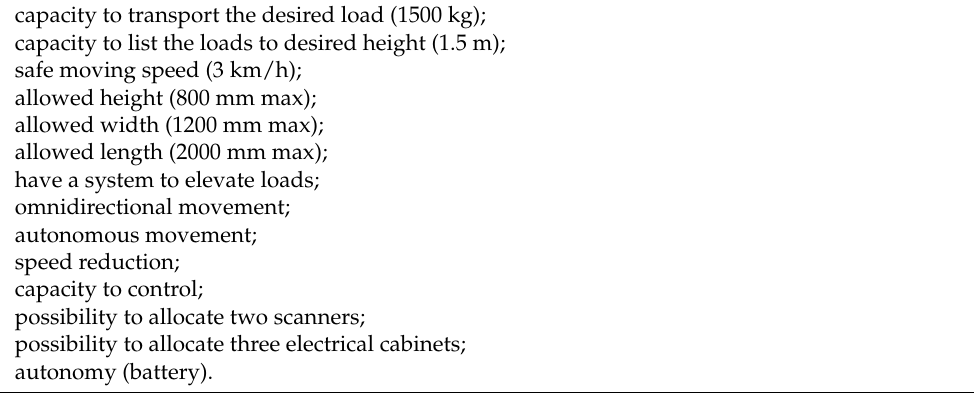
Table 3. Key technical requirements.